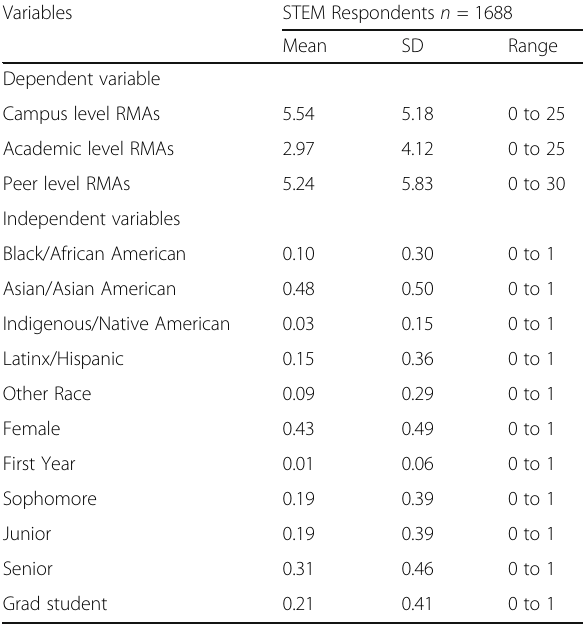
Table 2 Descriptive statistics for STEM respondents